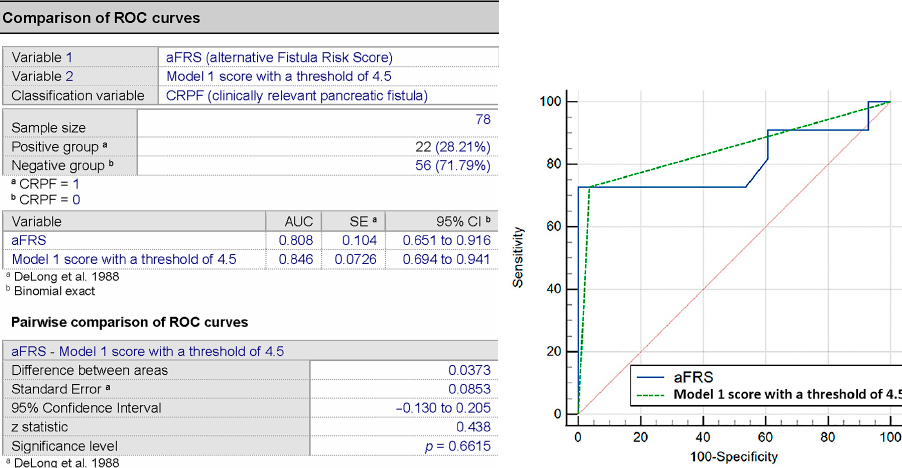
Figure 5. AUC for Model 2 using 3 parameters (the preoperatively estimated pancreatic remnant volume, the main pancreatic duct diameter, the unenhanced liver density).